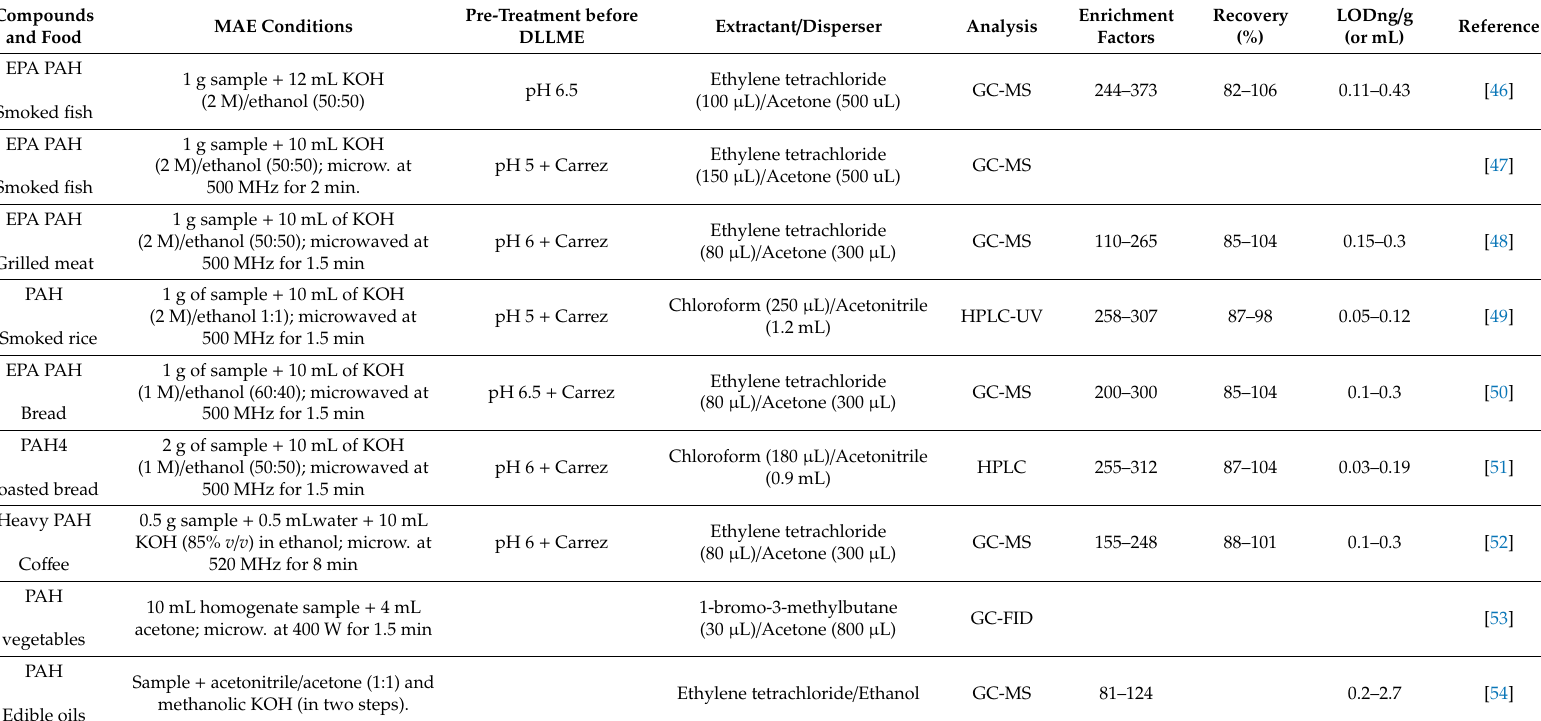
Table 2. Summary of recent studies combining MAE (MAS) with DLLME for determining hydrocarbon contaminants in